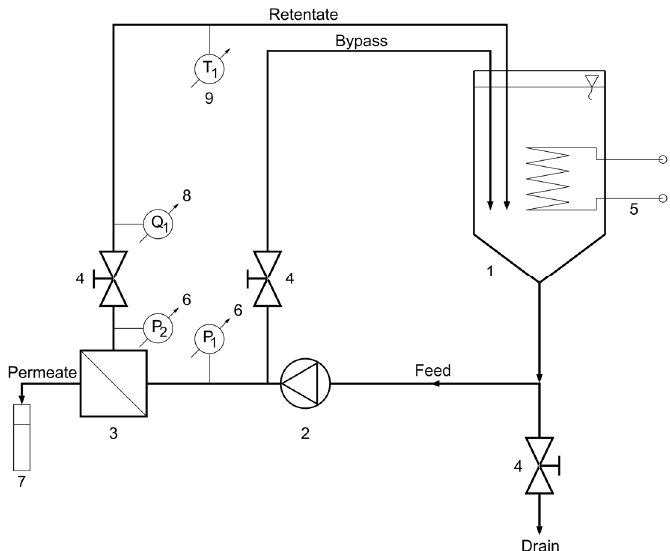
Figure 2. Schematic flow diagram of crossflow reverse osmosis (CFRO) equipment. 1—feed tank, 2—pump, 3—reverse osmosis membrane module, 4—valve, 5—heat exchanger (cooler/heater), 6—manometer, 7—measuring cylinder, 8—flowmeter, 9—thermometer.